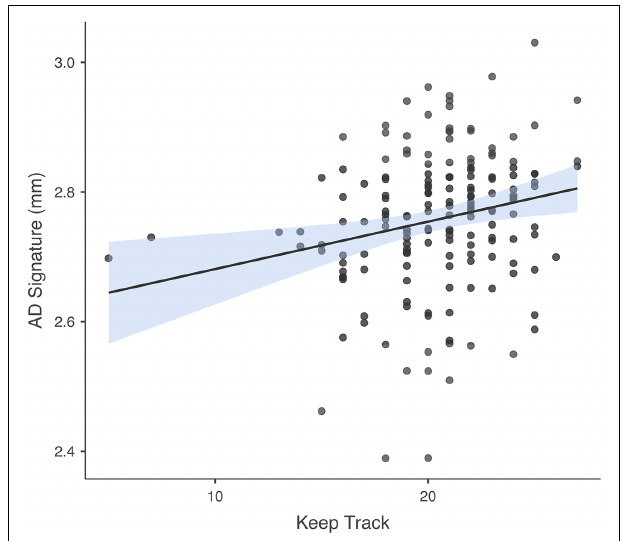
FIGURE 4 | Association between AD signature and Keep Track task. Scatterplot depicting the raw association between the AD Signature mean cortical thickness and the Keep Track task.